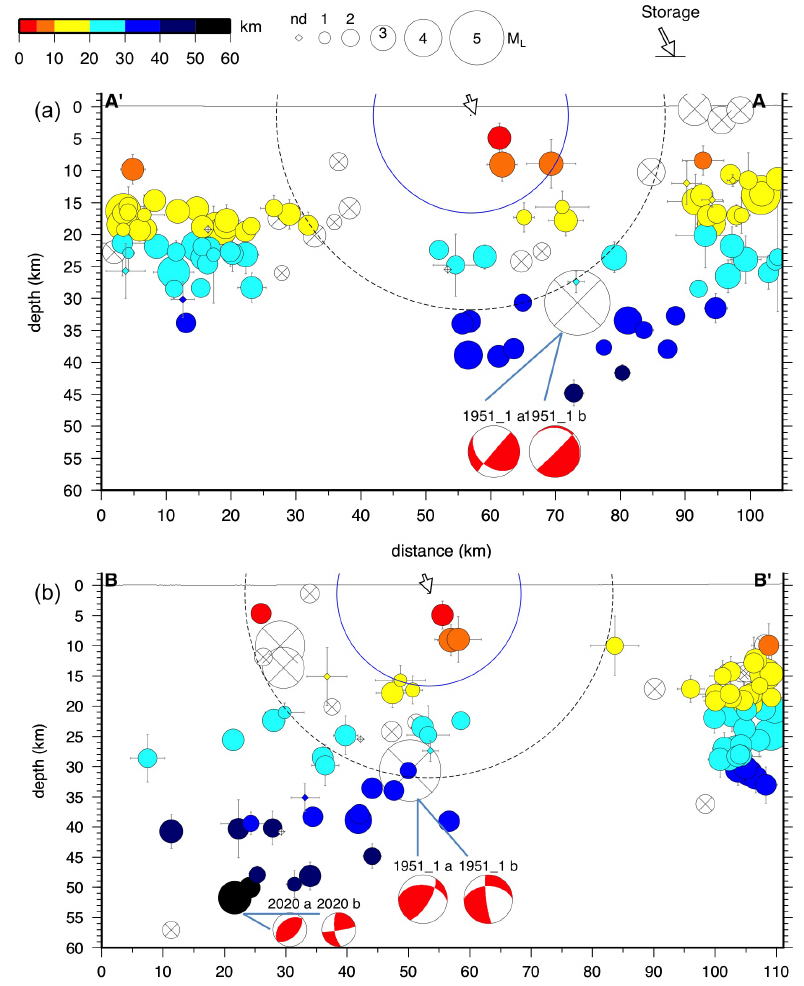
Figure 9. Vertical cross sections of the relocated earthquake catalogue. (a) SW–NE cross section (AA’ in Fig. 8) in which earthquakes within a 30km thick stripe centred on the trace line are projected; (b) NW–SE cross section (BB’ in Fig. 8), transversal to (a) , with the same thickness. The reservoir is indicated by the arrow; the OD and ED domains are represented by black-dashed-line and blue-line half-circles, respectively. White crossed circles represent earthquakes with large standard errors in location (horizontal error ERH > 5km, or vertical error ERZ > 10km): error bars represent the statistical standard errors as defined in Hypo71. The multiple solutions of focal mechanisms obtained by first-motion polarity, and projected on the section planes, are the ones given in Table 3 for the events of 15 May 1951 (row 7) and 17 December 2020 (row 4), respectively. Other details as in Fig.